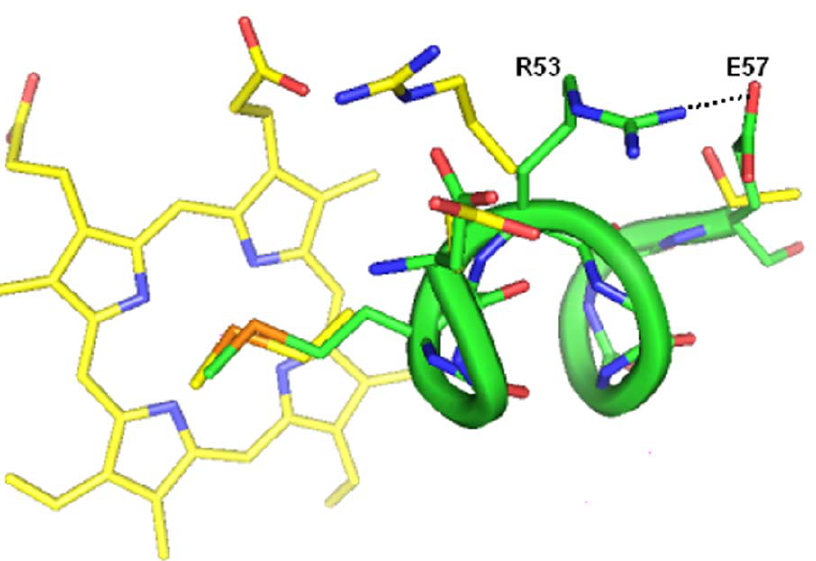
Figure 5. Comparative view of haem binding pocket of Mtb and M.smegmatis BfrA. The region 50–57 from Mtb SeMet-BfrA (protein chain shown as green tube and the amino acid side chains depicted as sticks) is superimposed with the same region including haem moiety (shown as sticks) from M. smegmatis (yellow) to highlight the flipped orientation of R53 in Mtb and loss of an interaction with haem. The flipped conformation that coincides with formation of a salt bridge between R53 and E57 (T57 in M.smegmatis ) is shown with a black dashed line.